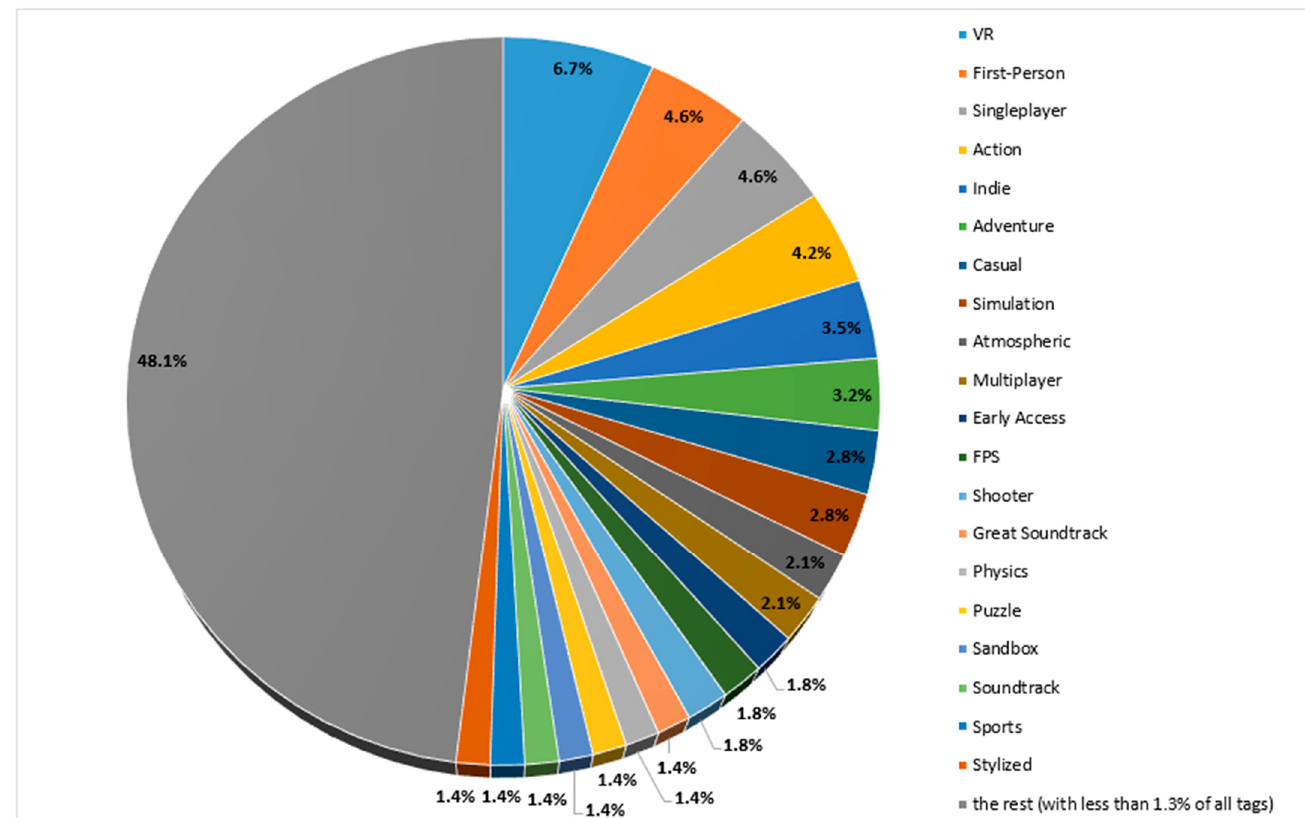
Figure 6. The number of a given tag of all tags for 19 top-rated VR applications on Steam (author’s own study based on data from [35]) [state on 6 July 2022].